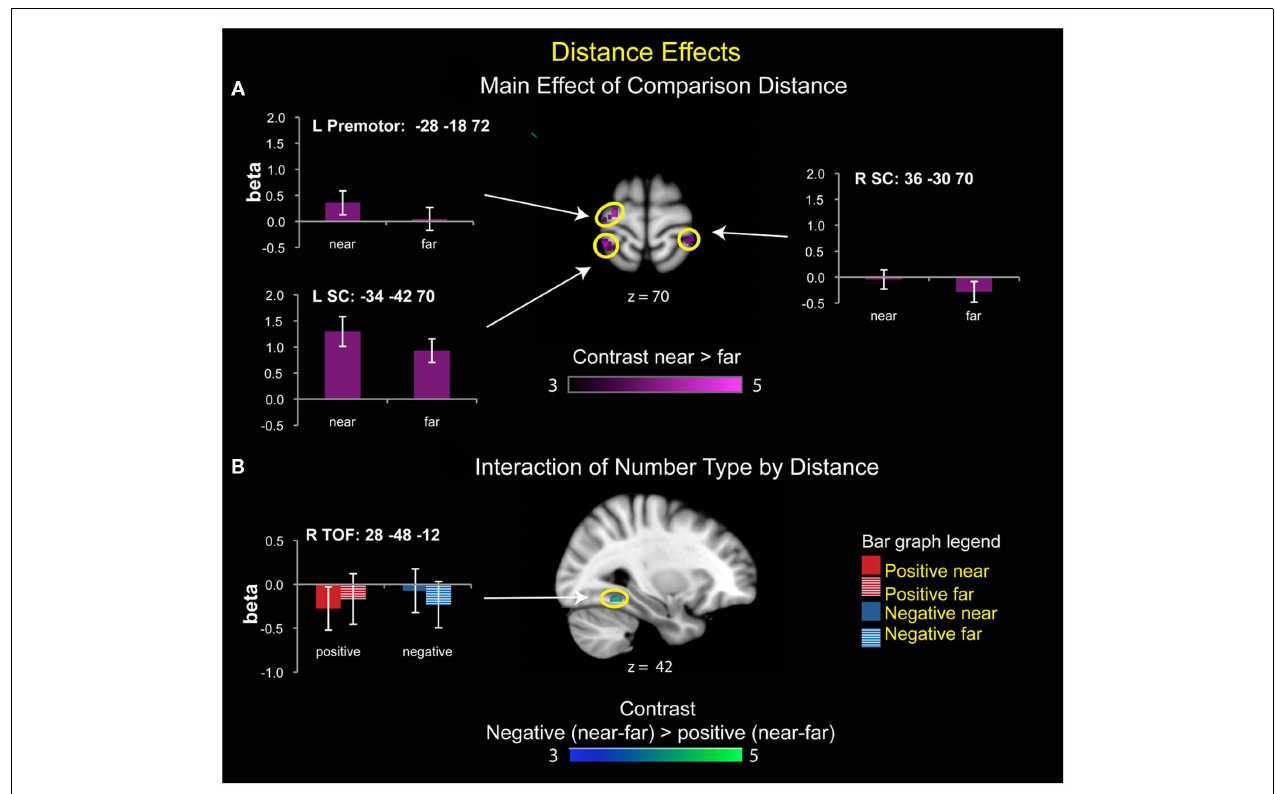
with number type in the right temporal–occipital fusiform cortex (TOF), reflecting greater deactivation for near than far comparisons for positive numbers, and greater deactivation for far than near comparisons for the negative